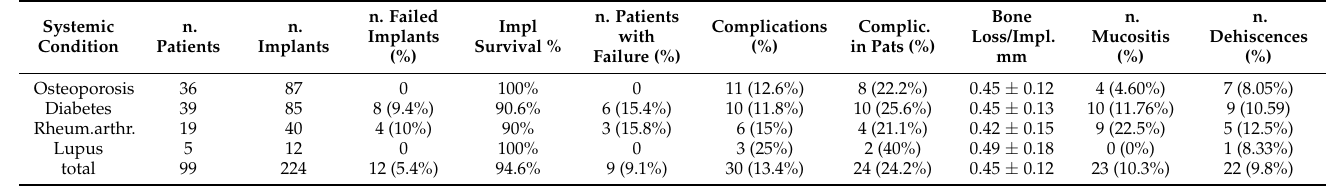
Table 4. Summary of the main results after 5-year follow-up, divided by systemic disease. Systemic n. Condition Patients